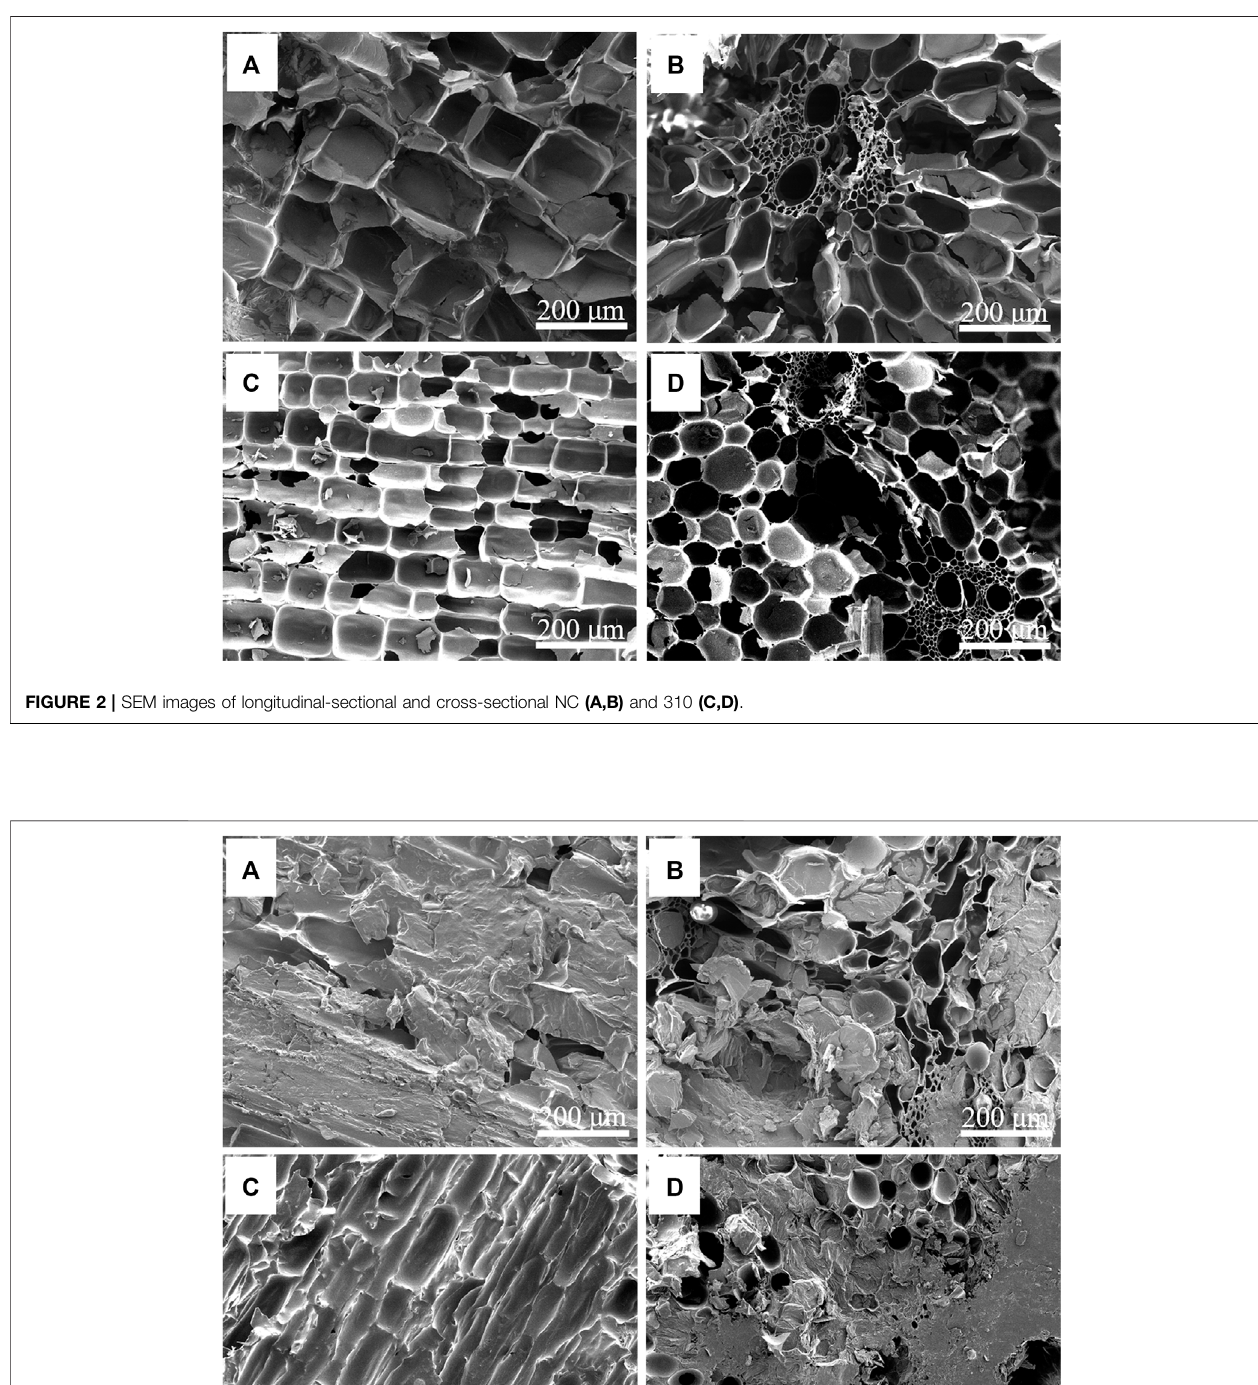
Frontiers in Chemistry |